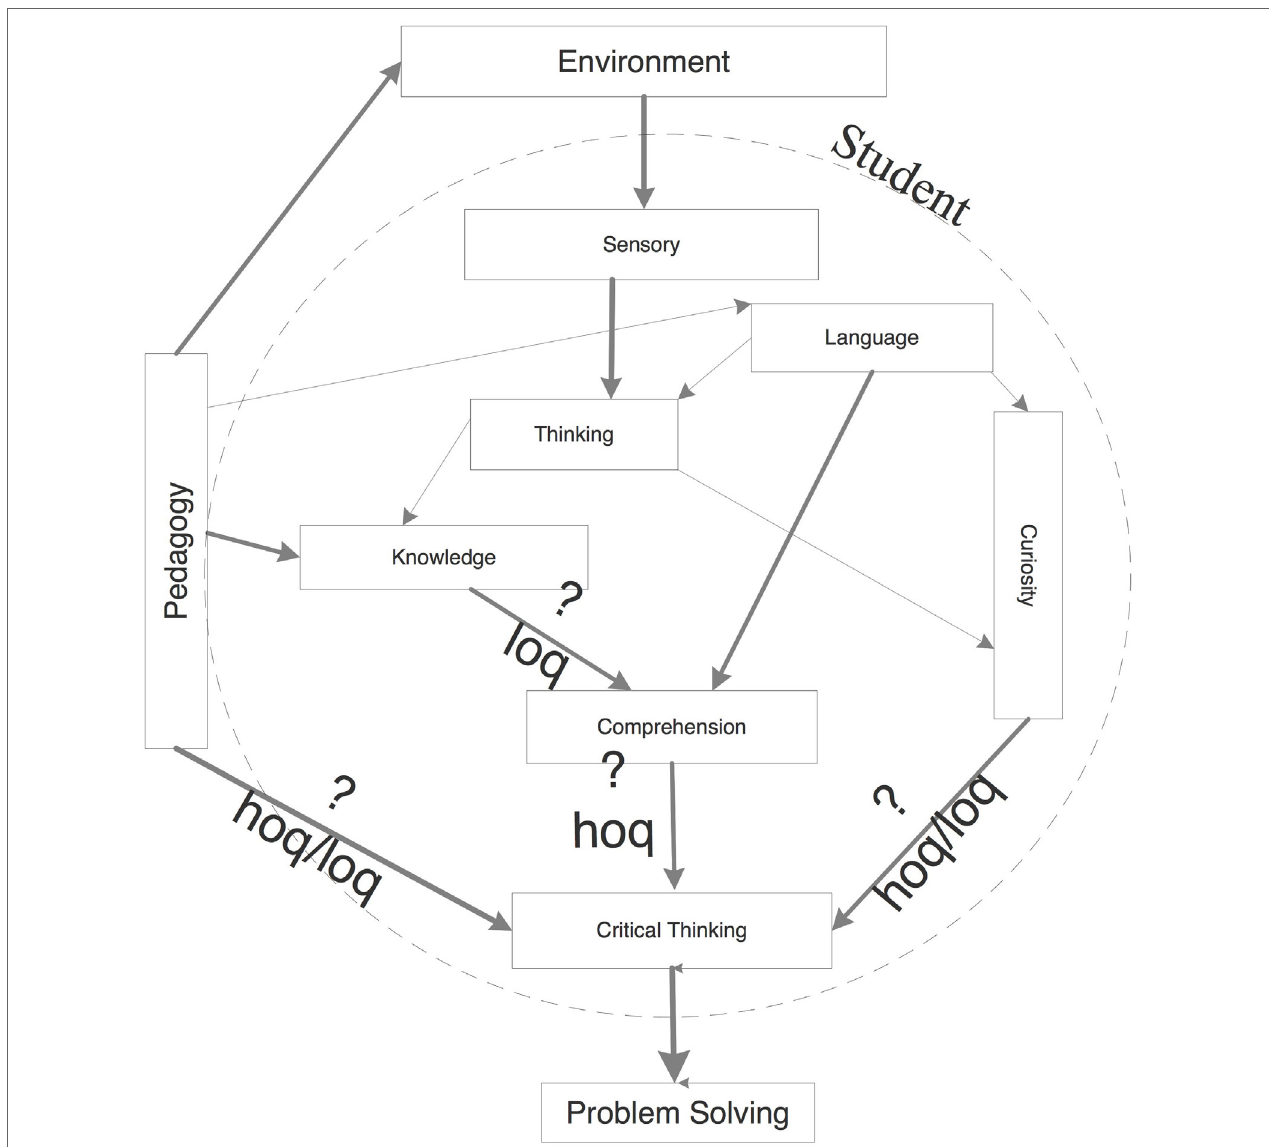
FiGUre 2 | Language-comprehension